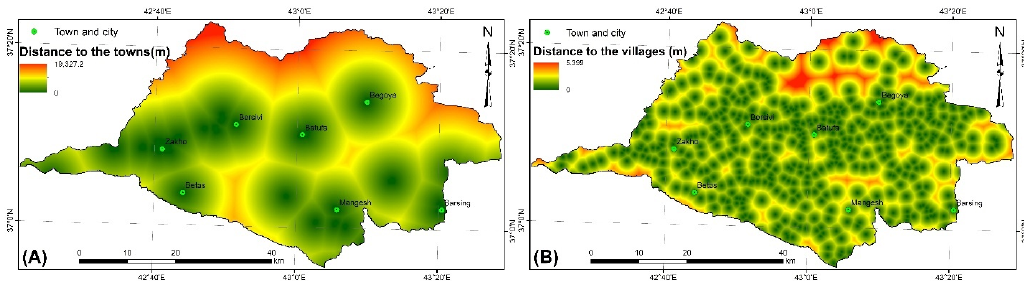
Figure 10. Maps of the factors: ( A ) distance to towns and cities, and ( B ) distance to villages.